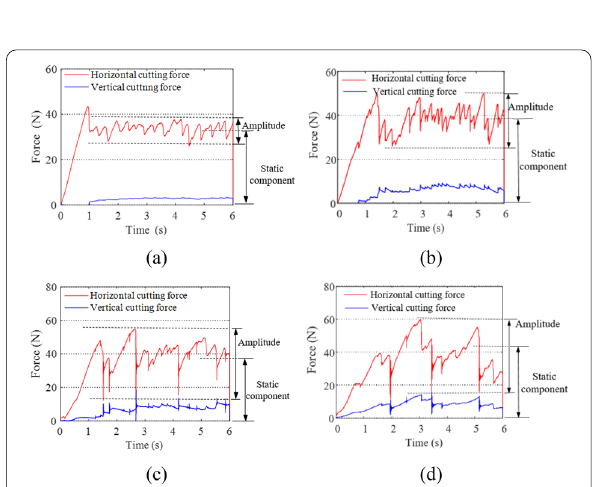
Figure 12 Cutting forces with the depth of cut of 130 μm: a Mode #1, b Mode #2, c Mode #3, and d Mode